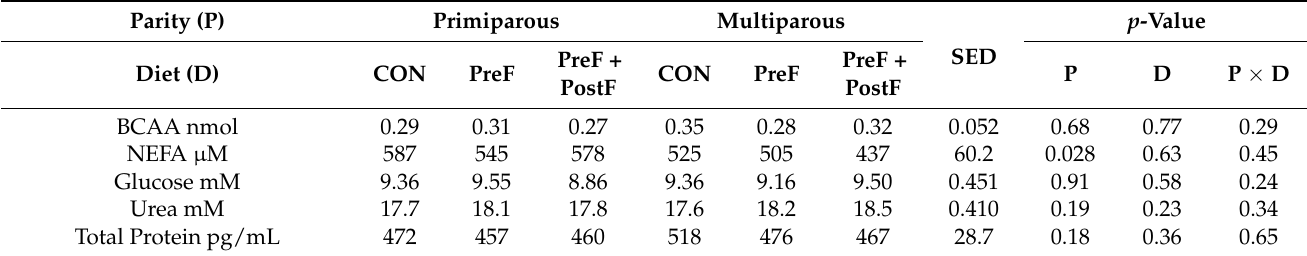
Table 8. Plasma metabolites of piglets on D10 born to sows fed either a control diet (CON) or SIMLUC 2 diet fed pre- farrowing (PreF) or fed both pre-farrowing and 10 days post-farrowing (PreF + PostF). Parity (P) Primiparous Diet (D) BCAA